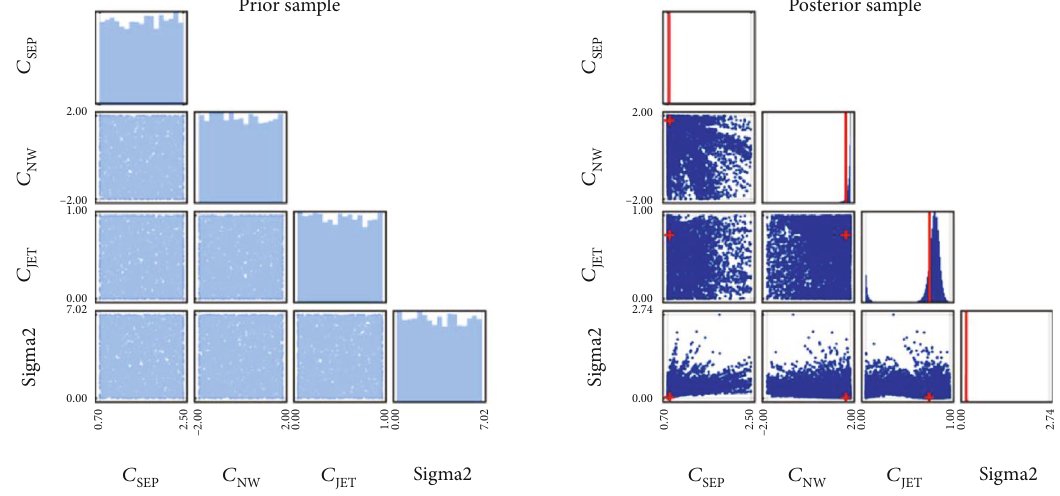
Figure 15: Prior and posterior distributions of RP (axisymmetric base).